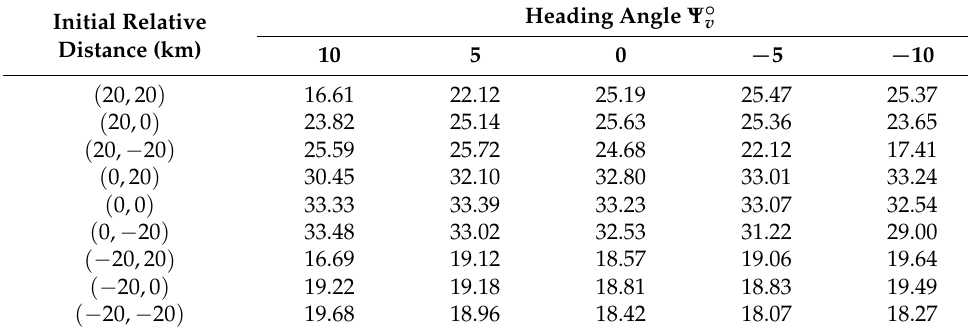
Table 7. Miss distance (m) with initial flight path angle θ = 0 ◦ .